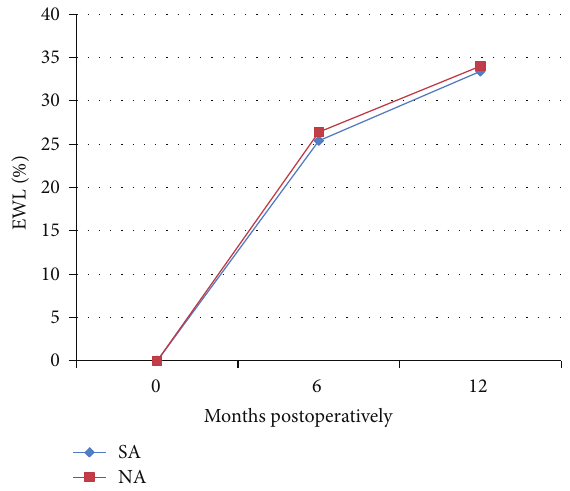
Figure 1: Percent excess weight loss (%EWL) in each group, after gastric banding (LGB). SA: substance abuse cohort; NA: no substance abuse cohort.